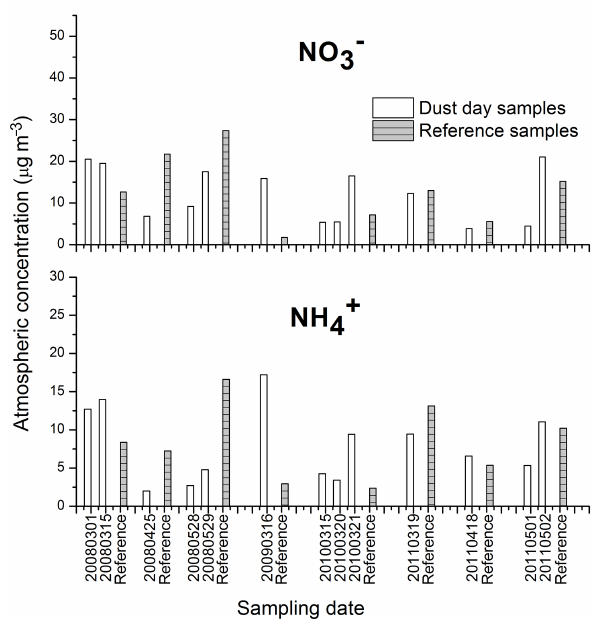
Figure 3. Mass concentrations of NH + ples collected at the Baguanshan site on dust and reference